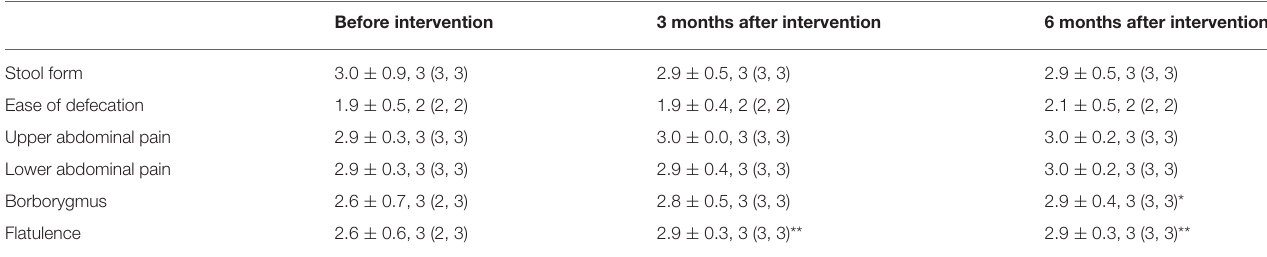
TABLE 4 | Effects of probiotics on stool form and gastrointestinal symptoms. Before intervention 3 months after